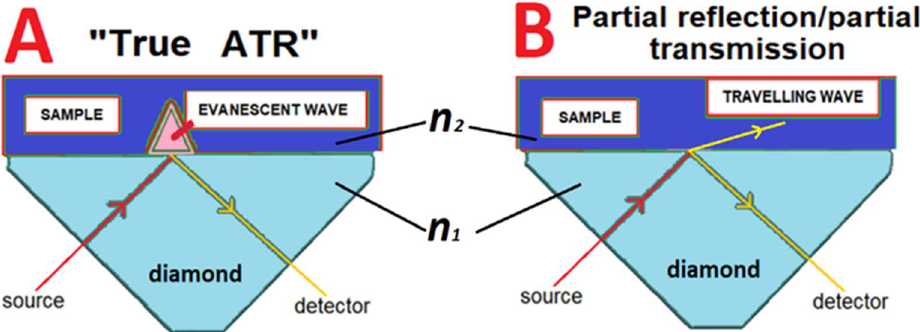
Figure 1. ATR apparatus configuration. ( A ) “True ATR” mode, with total reflection at the diamond/sample interface, producing an evanescent wave; ( B ) partial reflection/partial transmission mode, where some of the signal is transmitted into the sample at the diamond ( n 1 )/sample ( n 2 ) interface as a continuing travelling wave.